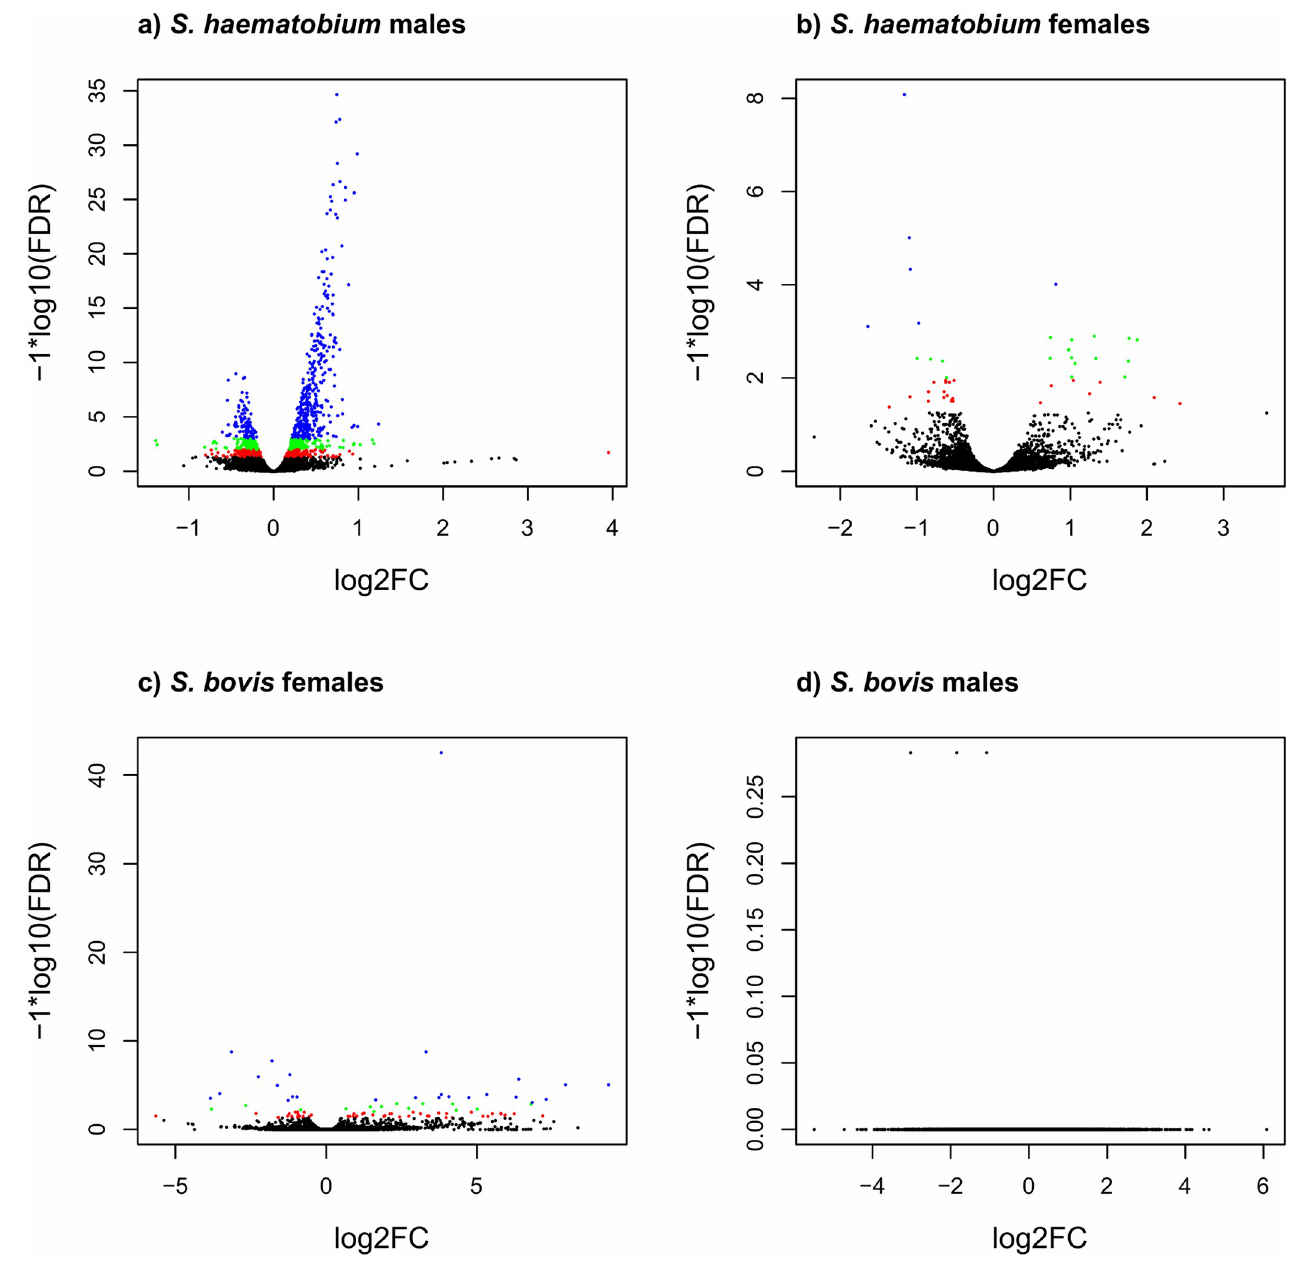
Fig 4. Genes expression profiles in hetero-specifically compared to homo-specifically paired worms. Volcano plots showing the log transformed adjusted P-values ( i . e .,FDR) and the log fold changes for the 18,648 unique genes of the reference transcriptome assembly for S . haematobium males a ), S . haematobium females b), S . bovis females c) and S . bovis males d). Black dots refer to non-significant genes regarding their expression profile (over an FDR of 5%). Red dots refer to differentially expressed genes at a FDR of 5%, green dots refer to differentially expressed genes at a FDR between 5% and 1% and blue dots refer to DEGs at a FDR between 1% and 1